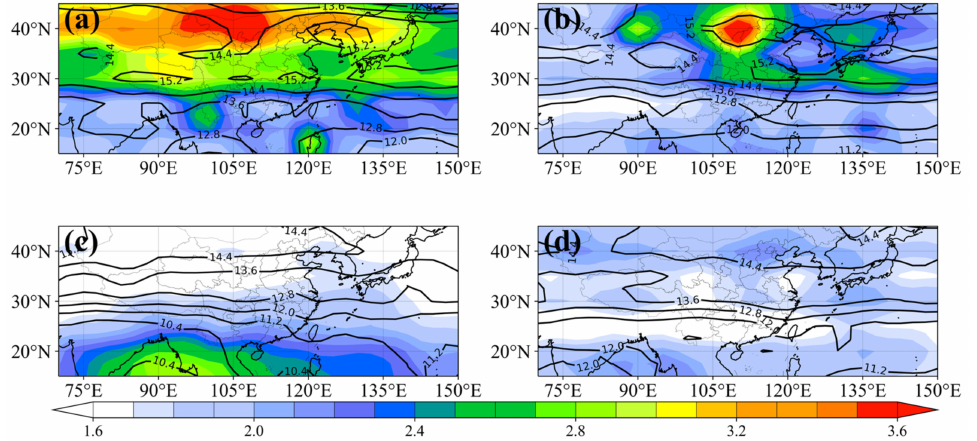
Figure 4. Distribution of the seasonally averaged spectral amplitude E ∗ (color shading; units of 10 4 J/kg (1/m) − 1 ) and the vertical characteristic wavelength (solid black line; units of km). ( a ) DJF, ( b ) MAM, ( c ) JJA, and ( d )